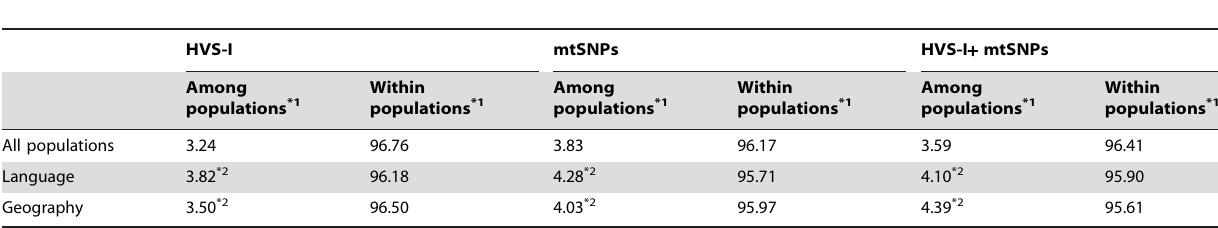
Table 3. Apportioning of genetic variance considering different genomic regions (HVS-I, mtSNPs, and both in combination) and groups (populations, language families and